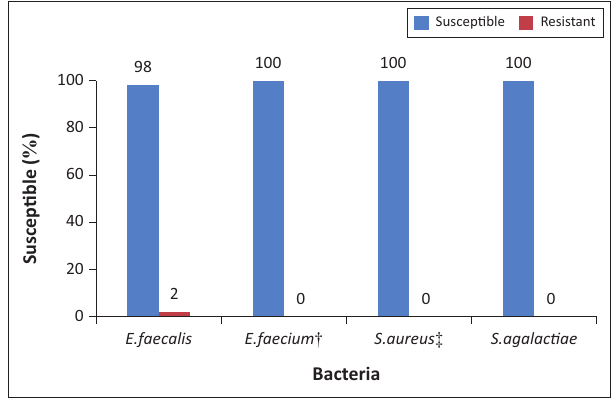
FIGURE 2: Antimicrobial susceptibility of urinary gram-positive cocci to